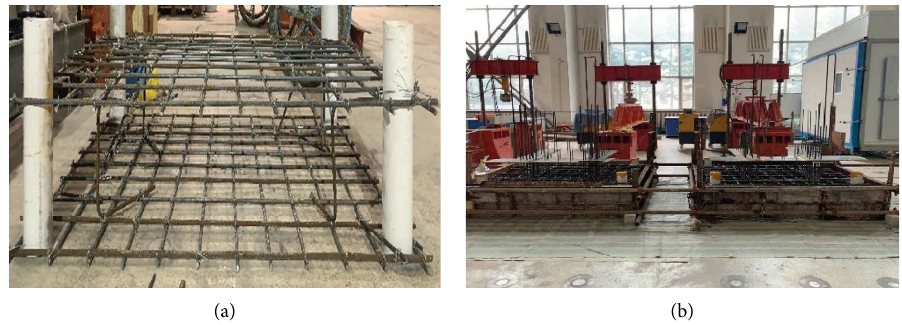
Figure 8: Manufacturing process of the base skeleton. (a) Base reinforcement skeleton. (b) Bottom supporting mold.